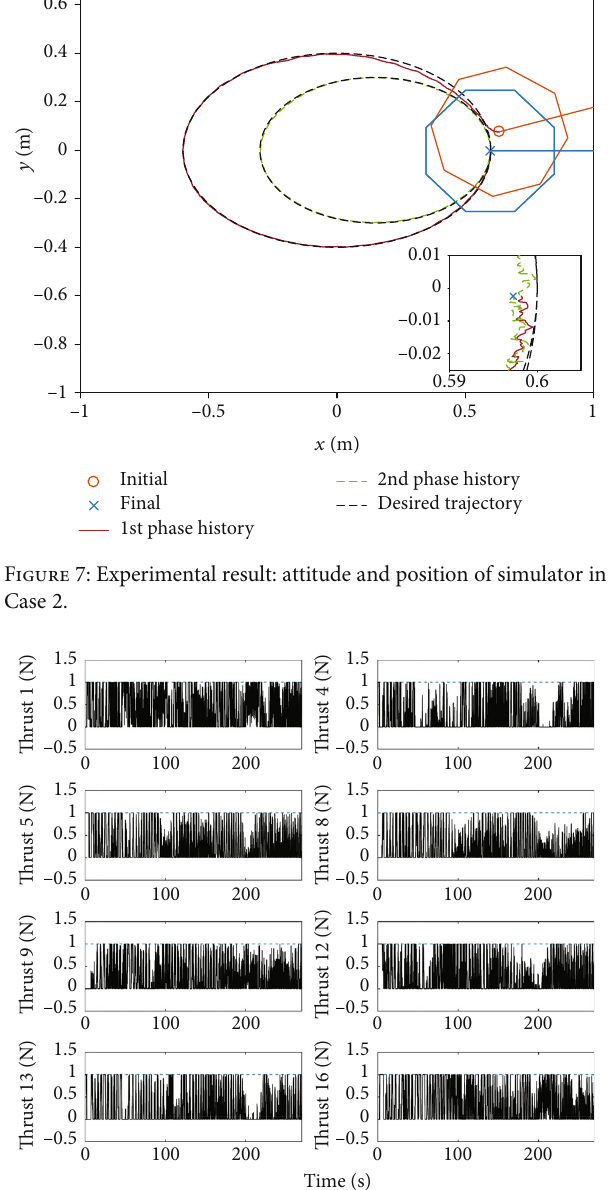
Figure 8: Experimental result: command control force of each thruster in Case 2.